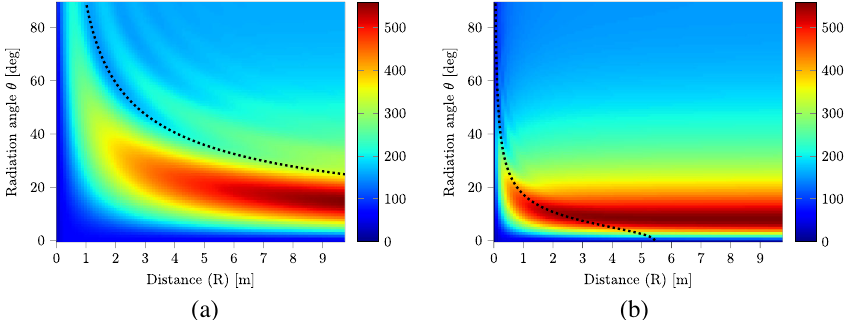
FIG. 5. The angular distributions 0.3 and 5.7 GHz for β ¼ 0 . 99 as a function of monitor distance from the target. The target size is set ¼ 1 m. Equation (13) scaled with 2 π is shown as dotted lines which separate wave and to 1 . 4 βγλ for the reference wavelength of λ ref prewave zone.